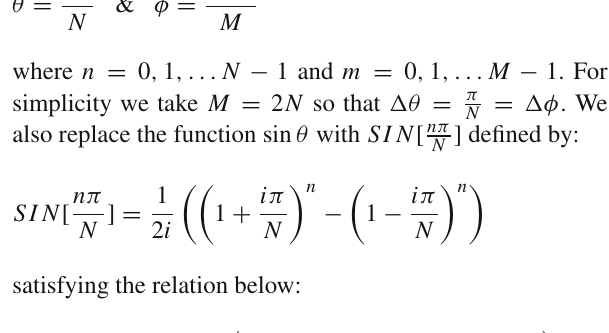
which is equal to 2 for a sphere. To test whether this is still satisfied in the discrete case, we write the expression of χ in the discrete space. For a sphere of radius one ( a = 1); hence, the scalar curvature is two, χ is given by: